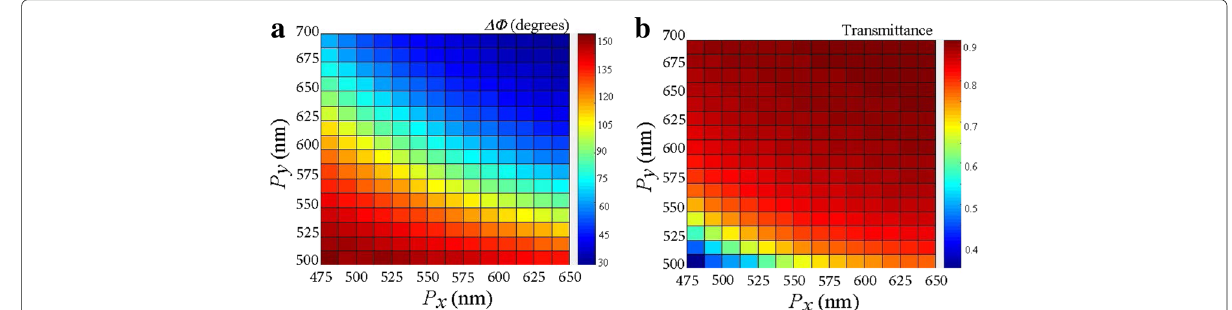
Fig. 6 a – b Variation of periodicities P x and P y at λ = 1.5 μ m. a Transmission phase and b